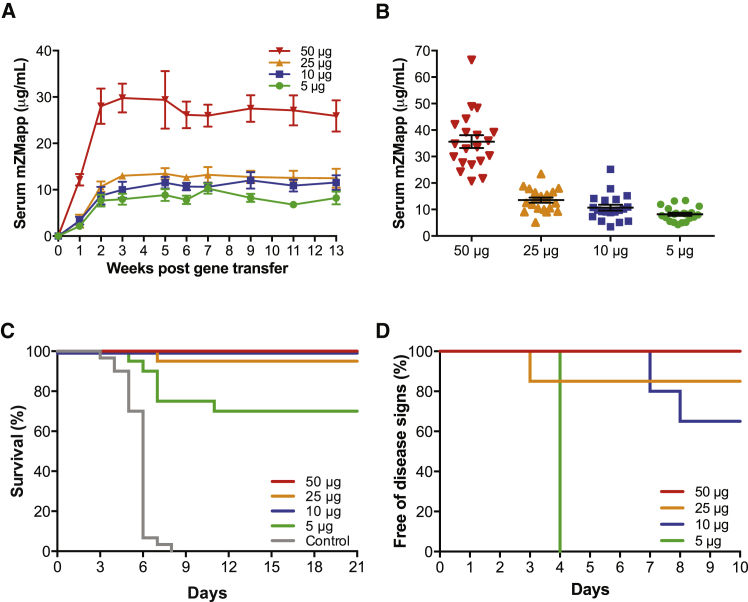
mZMapp Delivered by pDNA/EP Protects Mice from Lethal Ebola Virus Challenge(A) BALB/c mice (n = 6–9) were pretreated with 20 U of hyaluronidase and administered 5, 10, 25, or 50 μg H/L gWiz pDNA encoding each 2G4, 4G7, and 13C6 in muscles of separate limbs followed by EP. Total serum mZMapp concentrations were measured by GP binding ELISAs. All data are presented as mean ± SEM. (B–D) BALB/c mice (n = 20/group) were pretreated with 20 U of hyaluronidase and administered 5, 10, 25, or 50 μg of H/L gWiz pDNA per Ebola mAb that comprised the mZMapp cocktail (2G4, 4G7, and 13C6) or 150 μg of H/L gWiz pDNA of S139/1 as a control. (B) Blood was collected 14 days after pDNA/EP and analyzed for total mZMapp concentration by ELISA. Each point represents the value from an individual mouse. Error bars indicate mean ± SEM. (C) The mice were challenged 28–31 days after pDNA/EP administration with 100 PFU of mouse-adapted Ebola virus and monitored for lethality for 21 days. The Kaplan-Meier plot depicting survival is shown. Significance (p < 0.0001, log rank test) is reported for each group electroporated with DNA encoding mZMapp compared with the control group. (D) The mice were monitored daily for onset of signs of disease following challenge, and the Kaplan-Meier plot depicting animals remaining free of disease signs is shown.